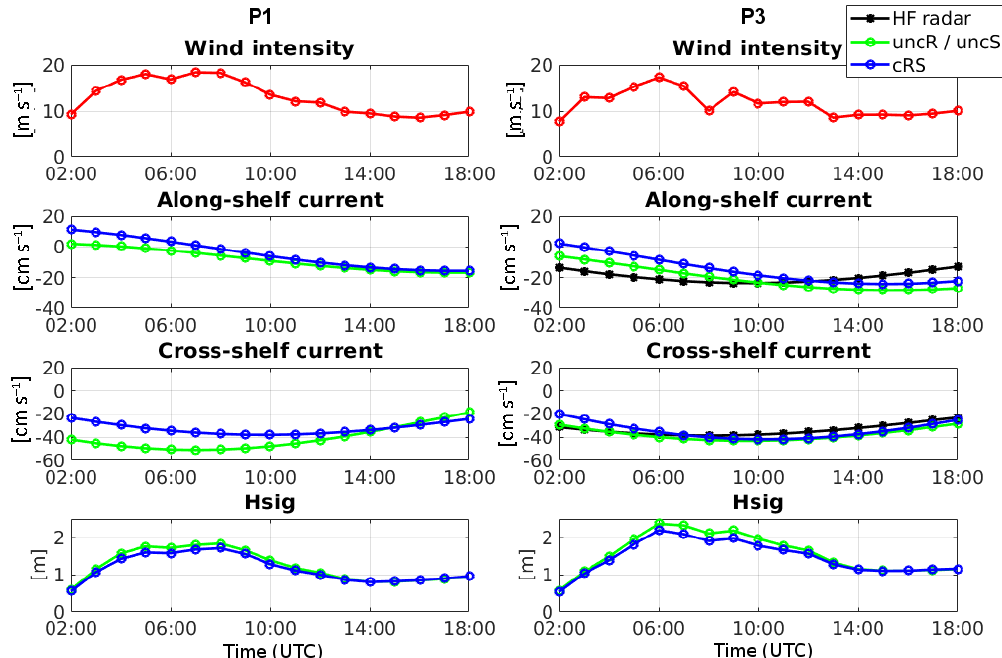
Figure 5. Wind intensity, along- and cross-shelf subinertial surface currents and Hs time series at P1 and P3 during the wind-jet E3 event (25 April 2014). Negative values indicate offshore and southwestward directions. In red: the modeled wind intensity; in black: the HF radar data; in green: the uncR and uncS runs’ results; in blue: the cRS run